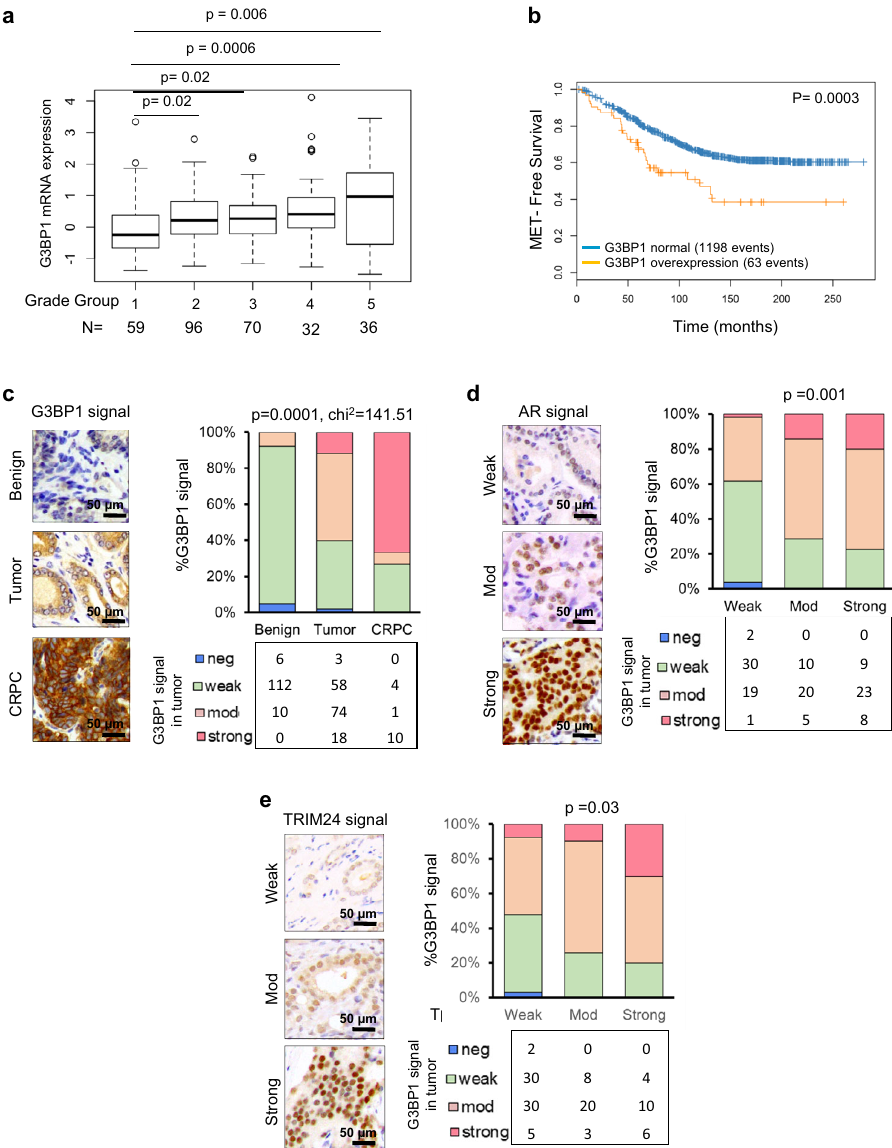
Fig. 3 G3BP1 overexpression is associated with aggressive PCa and correlated with increased accumulation of AR and TRIM24. a Stepwise upregulation of G3BP1 mRNA levels with increasing tumor group grade in the TCGA cohort patients 15 . Unpaired t -test. In box plots, the center line represents median value, box limits represent 25% and 75% quantiles, and the top and bottom lines represent minimal and maximal values, respectively. b Kaplan – Meier metastasis-free survival analysis of PCa patients. Patients were strati fi ed as low and high G3BP1 expression (log rank test, p = 0.0003). PCa patients undergoing radical prostatectomy and reaching metastasis postoperatively were used for analysis 37 . c Expression of G3BP1 in benign ( n = 128), primary PCa tumors (Tumor) ( n = 153), and CRPC ( n = 15). The scale bar represents 50 µ m. Paired t- test. p value is indicated in fi gure. d , e Correlation of G3BP1 protein and nuclear staining of AR ( d ) and TRIM24 ( e ). Paired t- test. The scale bar represents 50 µ m. For c – e , 60 benign prostate tissues, 73 localized prostate cancers, and 16 metastatic castration-resistant prostate cancer tissues were establishes a role for AR in G3BP1-SPOP ubiquitin signaling.